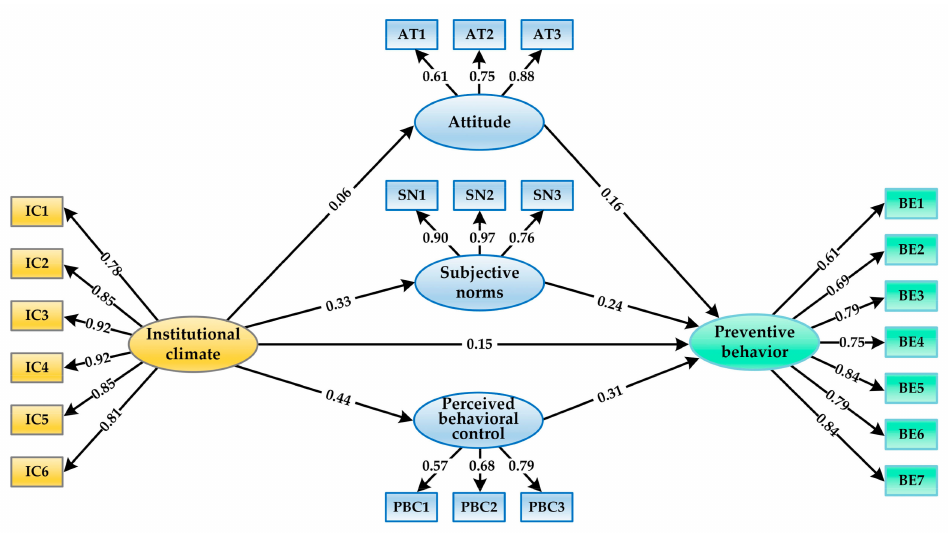
Figure 3. Results of the